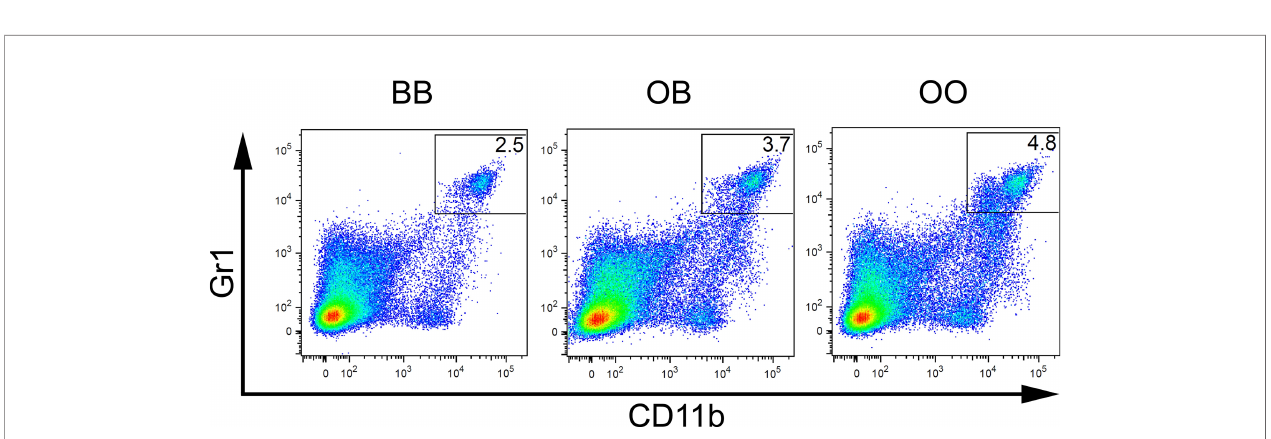
FIGURE 4 | Genetic in fl uence on frequency of CD11b + Gr1 + cells. Flow cytometry analysis of spleens of representative mice with BB, OB, and OO genotypes showing the Gr1/CD11b cell surface marker status of individual cells. O and B indicate the presence of O20 and B10 allele,